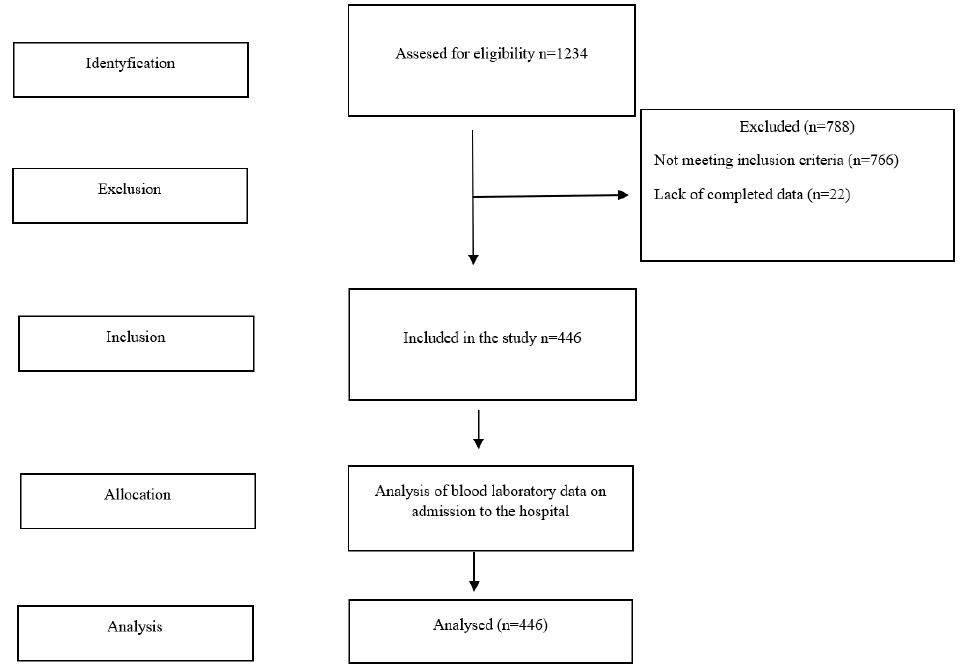
Figure 1. Study flow diagram.